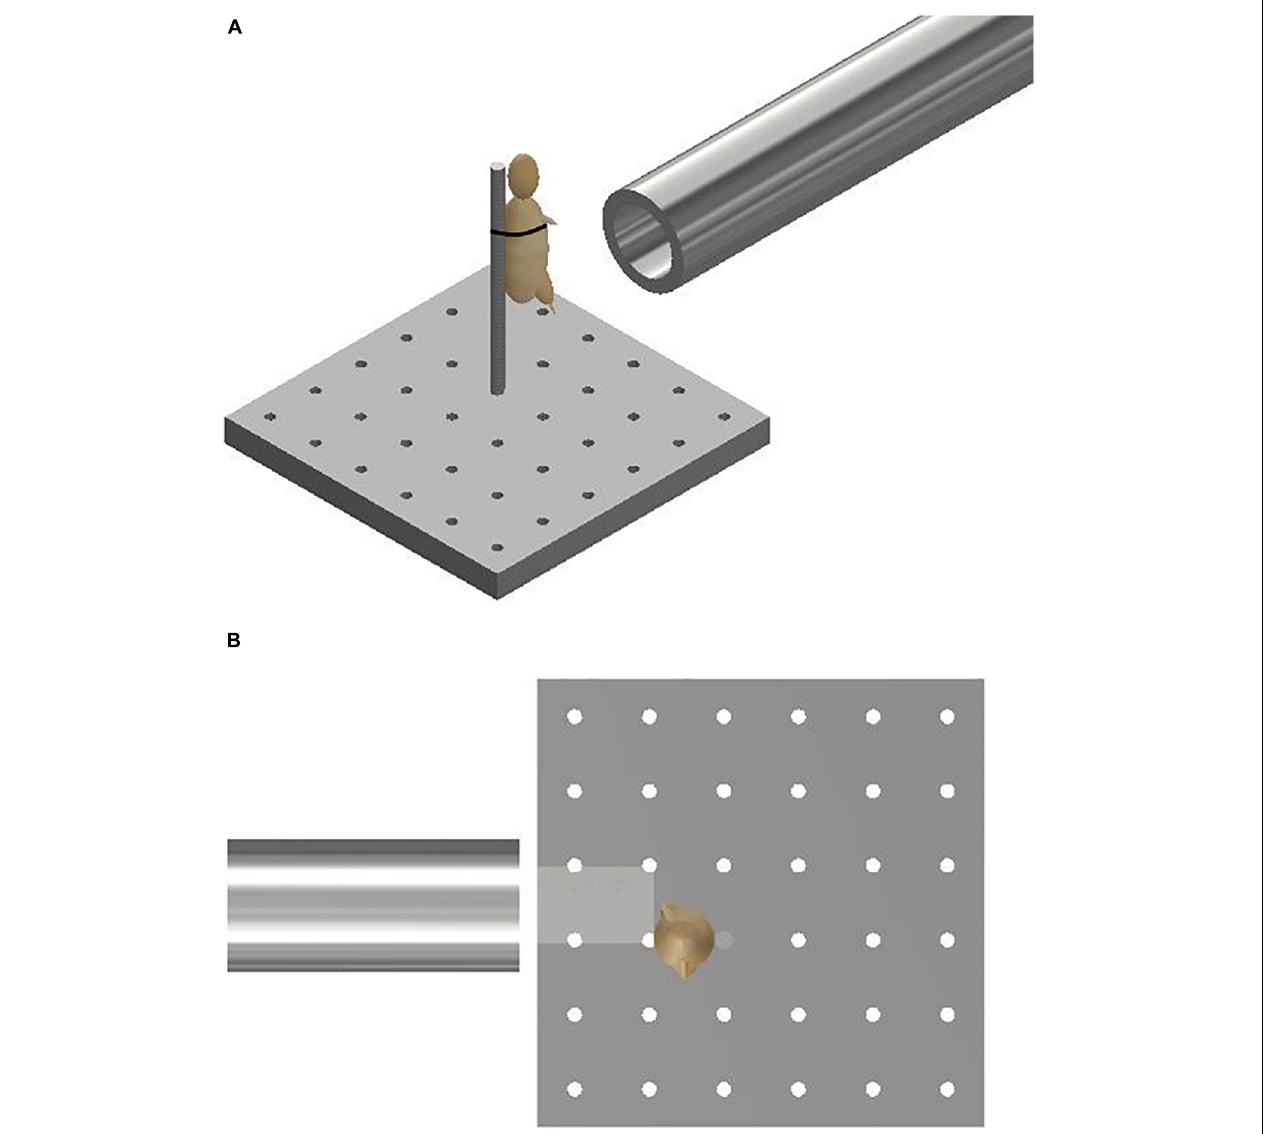
FIGURE 2 | (A) Schematic illustrating the experimental setup showing the gas-gun outlet with mounting platform and mouse. The mouse represented with a model. (B) Aerial view of schematic illustrating initial sandy gravel stream passing through distal outlet to impact with offset lower limb of mouse. The mouse is represented with a